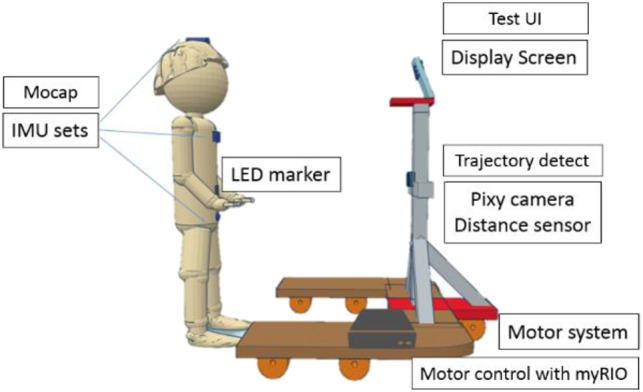
Schematic diagram of the assessment device. This evaluation tool consisted of a display screen, inertial measurement unit (IMU) motion capture (mocap), trajectory detection and motor system. There were 3 IMUs installed on segments of the subject.